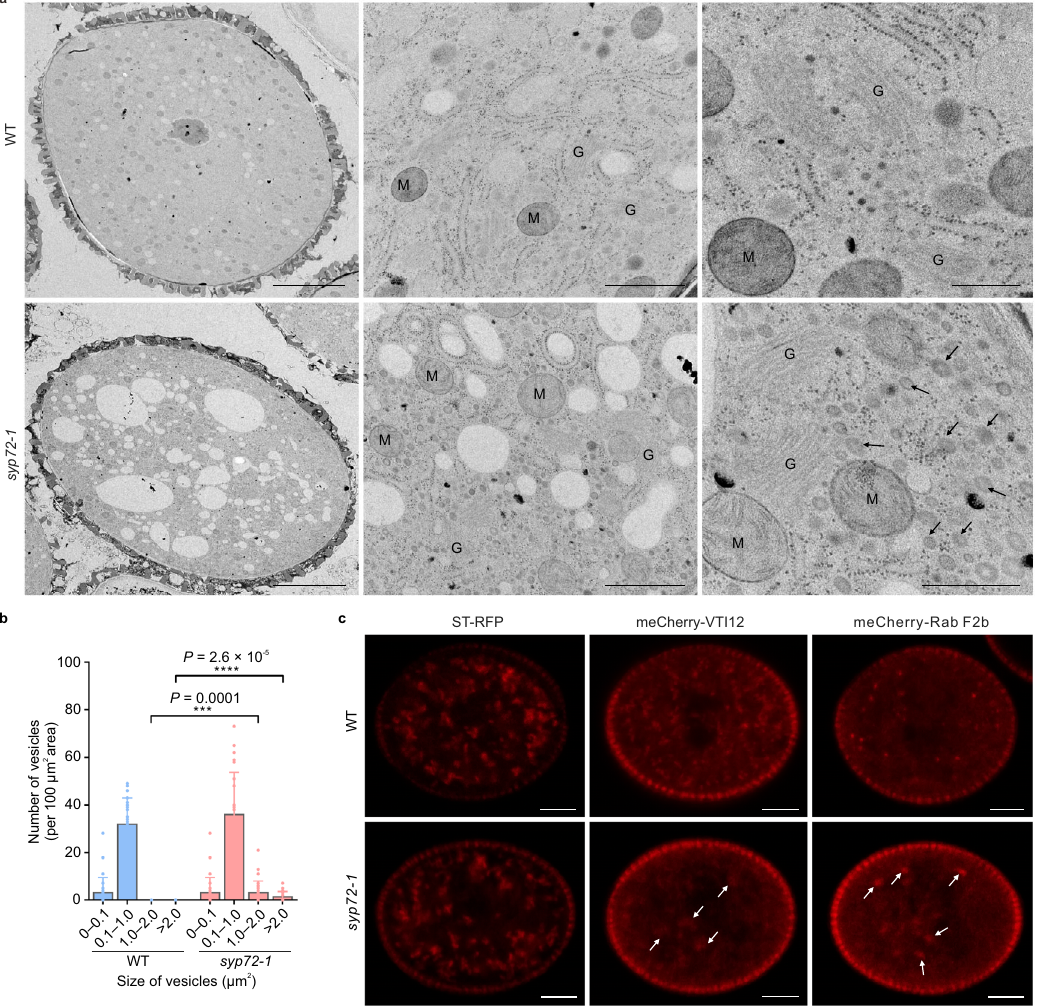
Fig. 5 syp72 mutation leads to abnormal distribution of TGN/EE and endosomes in pollen. a TEM analysis reveals the accumulation of endosome-like structures in syp72-1 pollen (bars: left, 5 μ m; middle, 1 μ m; right, 500 nm; n = 30 biologically independent pollen grains). M mitochondrion, G Golgi apparatus. Arrows indicate numerous endosome-like structures in the syp72-1 mutant. b The number of vesicles of different sizes in WT and syp72-1 pollen. Data represent the mean ± SD from 30 pollen grains ( n = 30). Two-tailed Student ’ s t test was used for statistical analysis (*** P < 0.001; **** P < 0.0001). c Representative images of pollen from WT and syp72-1 plants expressing ST-RFP (Golgi apparatus; n = 10 biologically independent pollen grains), mCherry- VTI12 (TGN/EE; n = 15 biologically independent pollen grains), and mCherry-Rab F2b (endosome; n = 13 biologically independent pollen grains). Arrows indicate abnormal accumulation of VTI12-labelled TGN/EE and Rab F2b-labelled late endosomes. Scale bars, 5 μ